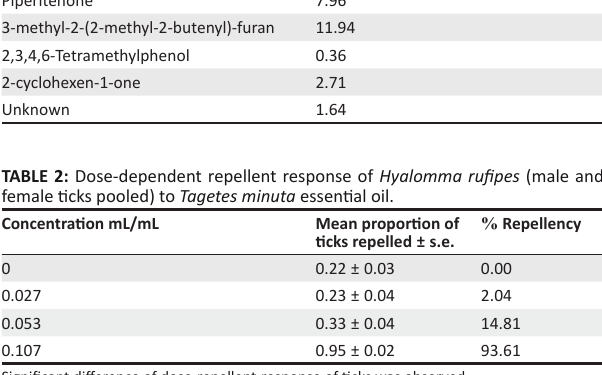
TABLE 3: Effective concentration needed to repel 50 % of ticks ( EC